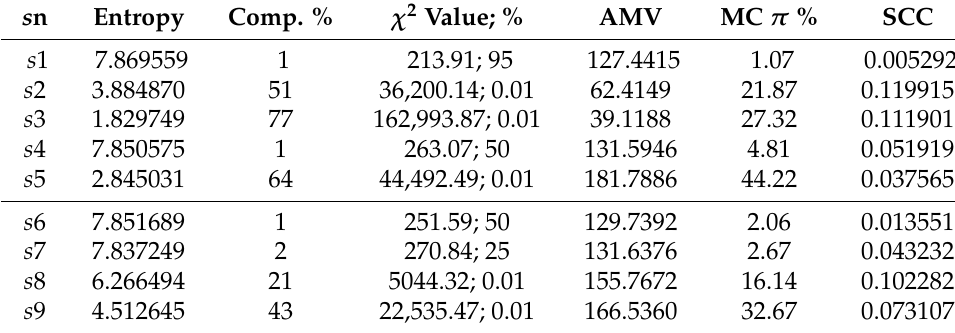
Figure 11. Scatter plots of sequences s 1– s 9, each with 100 × 100 bits. Table 2. Results of the six ent tests performed on sequences s 1– s